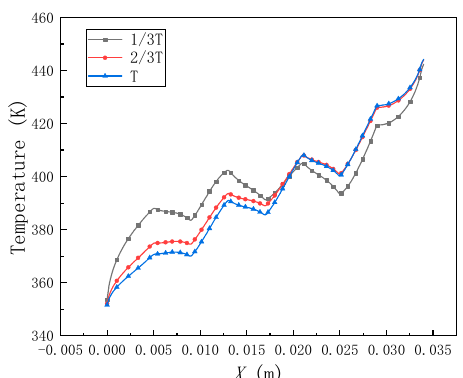
Figure 12. Temperature distribution along the heat transfer wall at different times.